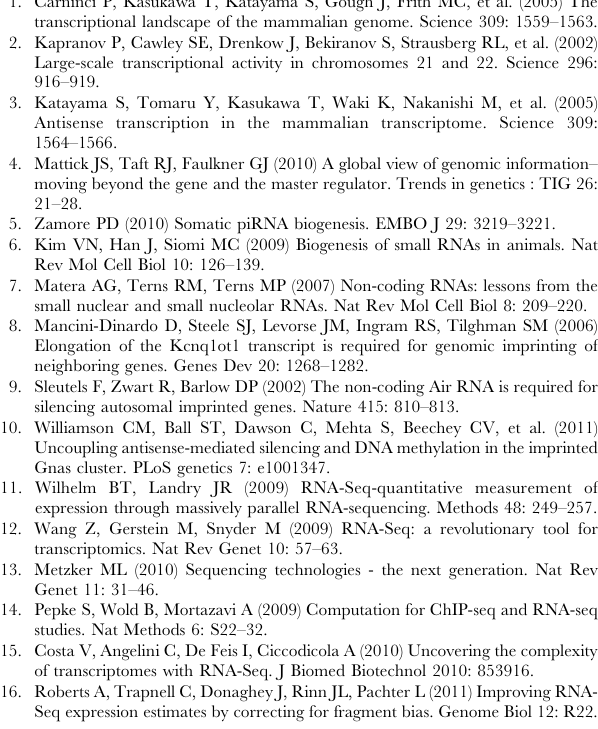
Figure S1 Optimisation and reproducibility of ribo- minus RNA-Seq in 14.5 dpc fetal head (FH). ( A ) Similar analysis as in Figure 1A for sequence tags obtained from FH tissue.